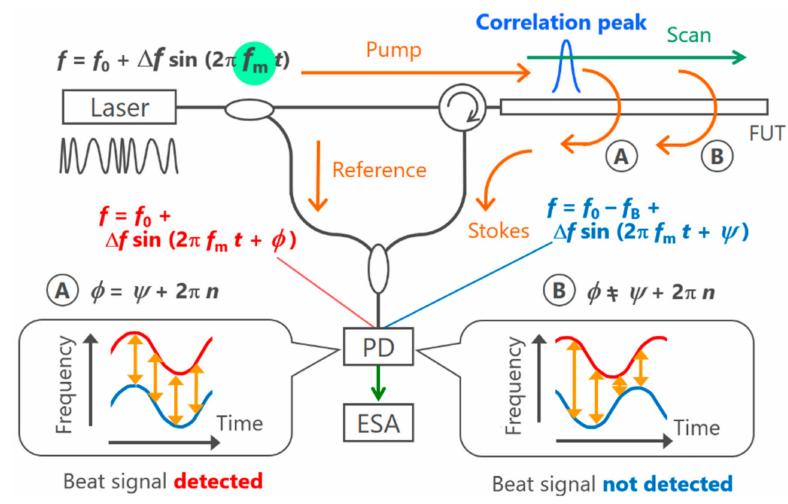
Figure 2. Operating principle of basic